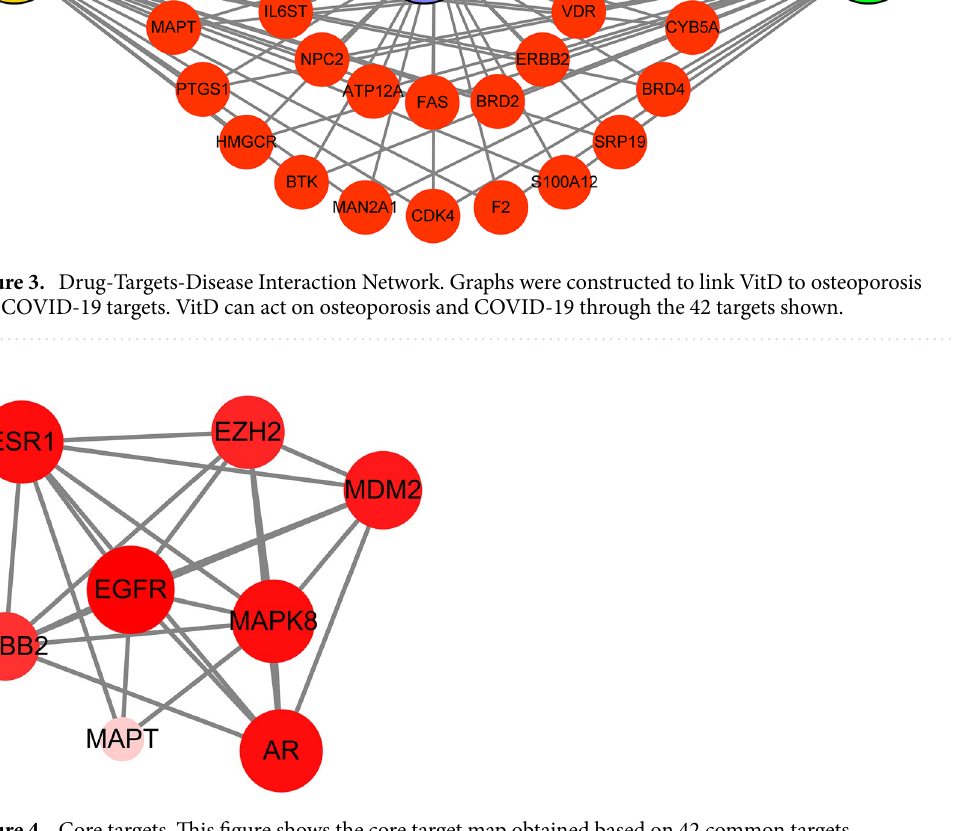
ously bind to the protein receptor. If the binding energy is < − 5.0 kJ mol or lower, it indicates that the two have the better binding ability 31 . Therefore, to further validate the results from the analyses of network pharmacol-